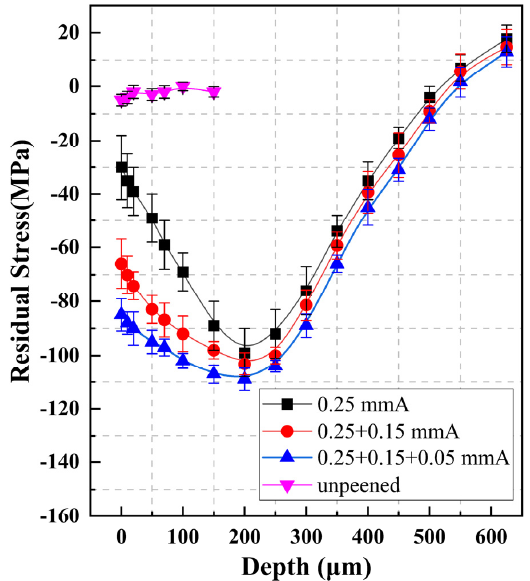
Figure 3. Residual stress of CNT/Al − Mg − Si alloy composite treated by multiple shot peening.